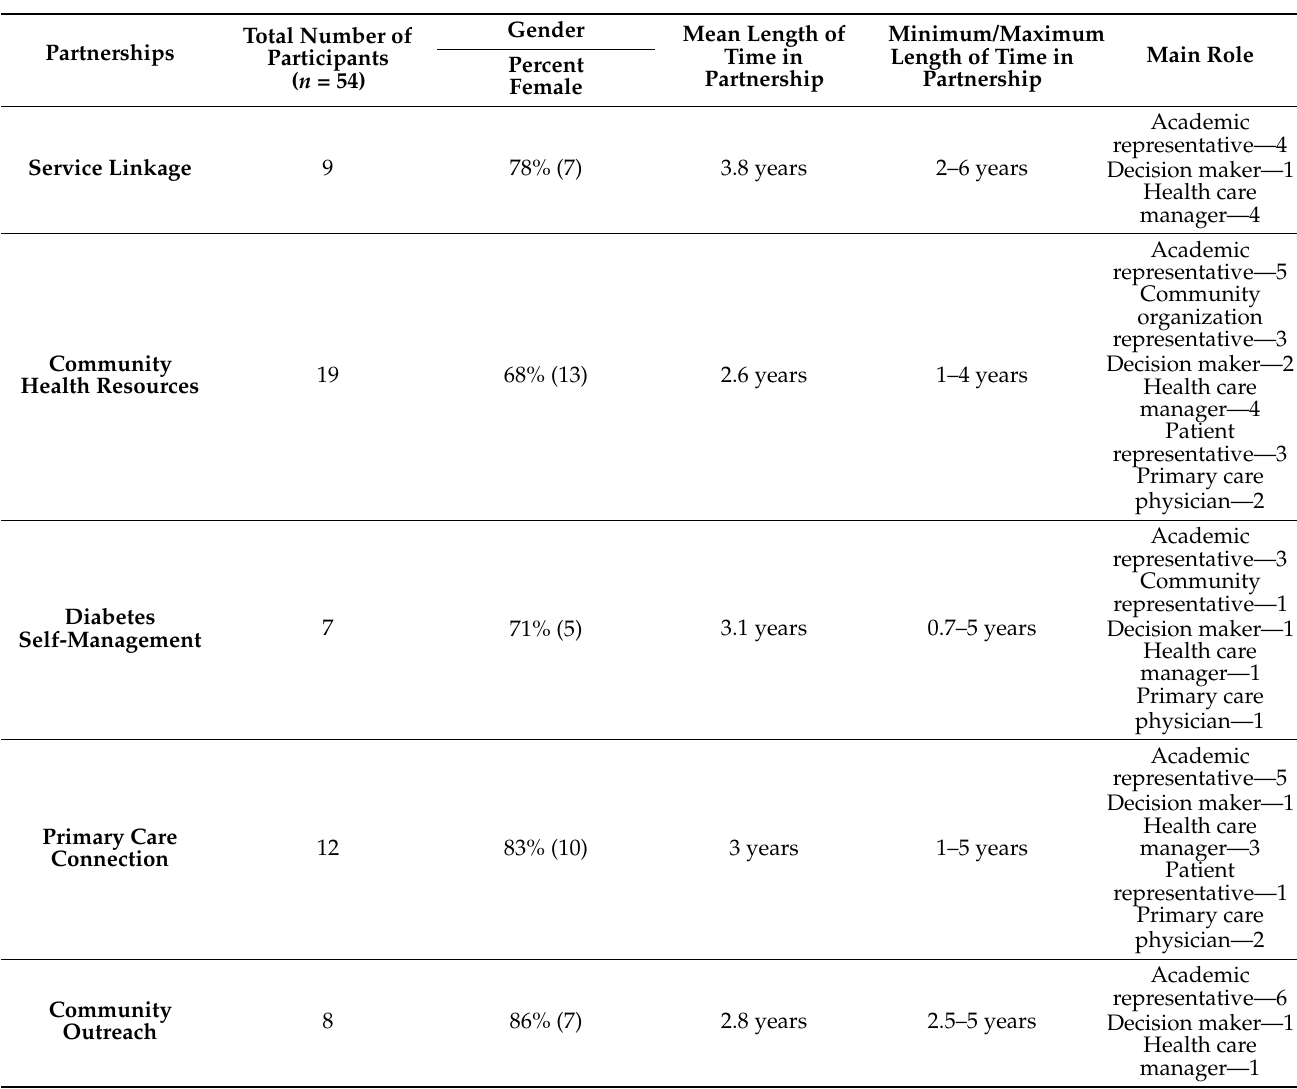
Table 2. Study sample characteristics per partnership ( n = 5) (reproduced from